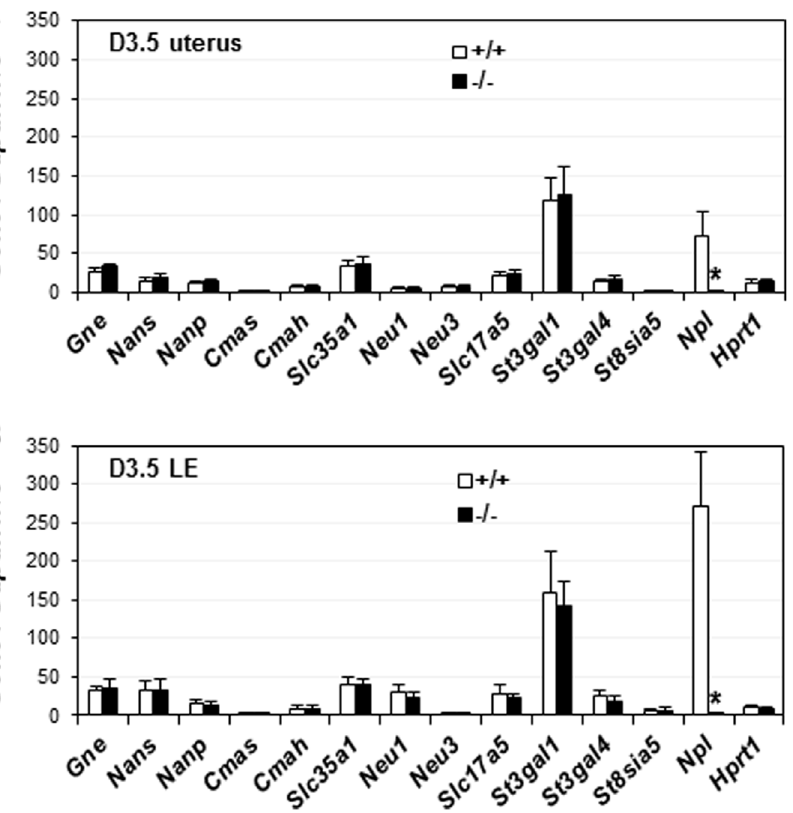
Figure 5. Deletion of Npl on the expression of sialic acid metabolism related genes in D3.5 uterus (A) and isolated LE (B), respectively. + / + , wild-type; 2 / 2 , Npl ( 2 / 2 ) ; X-axis indicated the names of the examined genes. Y-axis showed the normalized mRNA expression levels by Gapdh (glyceraldehyde 3-phosphate dehydrogenase) x10 3 . Hprt1 (hypoxanthine phosphoribosyltransferase 1) served as the second house- keeping gene. N=5–6. Error bars, standard deviation.